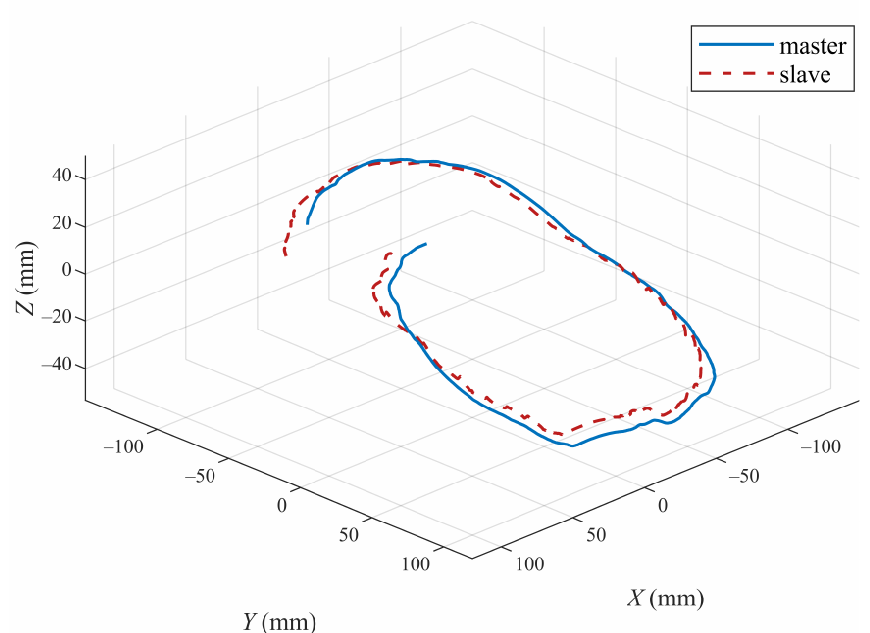
Figure 16. Tracking control performance of end-effectors of master and slave robots under experiment case